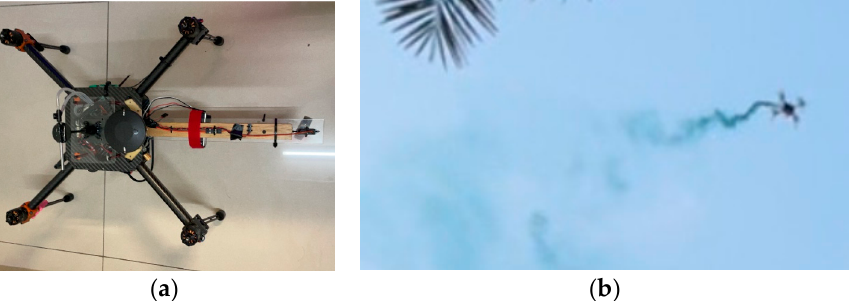
Figure 4. Spraying effects at the redesigned smoke tube position, should be listed as: ( a ) the smoke tube extension frame is at the rear; ( b ) effect after modification.